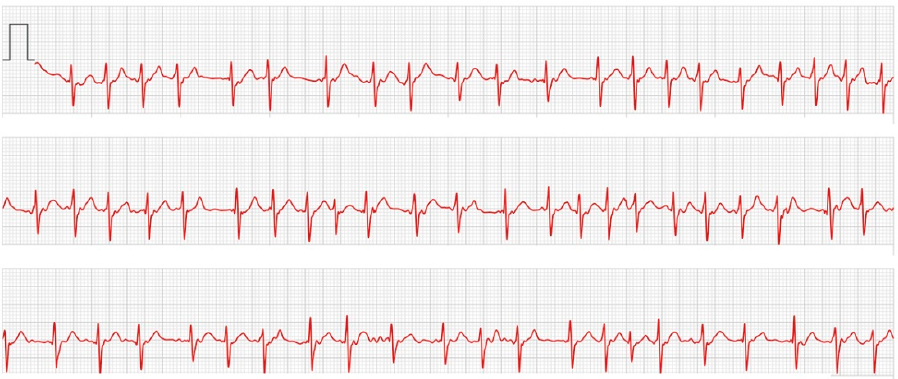
Figure 2. Paroxysmal atrial fibrillation was detected during the arrhythmic attack. The first 1 min of an electrocardiogram that was collected immediately after notification of the tachycardic episode. 25 mm/s, 10 mm/mV, iOS v.15.4.1, Apple Watch 4.2, algorithm v.1.